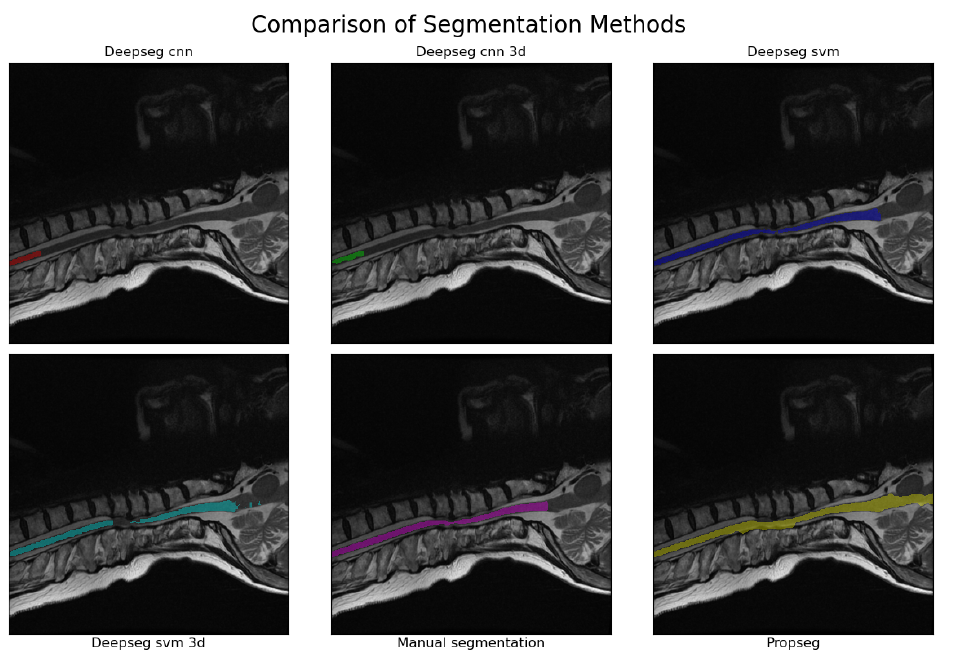
Figure 2. An example of the segmentations produced by each of the methodologies tested. The image used was that of a sagittal, T2w image from a patient with severe DCM (as evaluated by mJOA score). The manually segmented example is provided in the bottom center, with all others being produced via automated analyses using SCT [13]. The CNN kernel in particular seems to struggle when faced with spinal cord compressions, with the SVM kernel and propseg method having relatively minor issues in comparison (usually leaking or outright ignoring the compressed areas instead). This pattern appeared to hold true for all segmentations manually reviewed during the process to create Table 1. Table 1. Total number of segmentations resulting from each algorithm which were found to be “best-of-type” for a given patient. Ties were allowed, enabling one patient image to have up to two “best” segmentations.